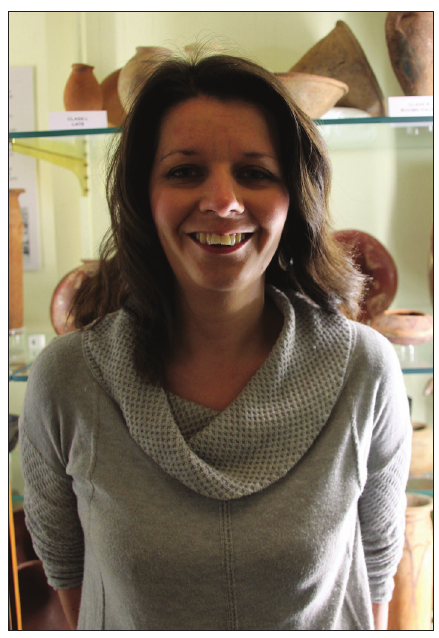
Figure 1: Alice Stevenson (Photo Lisa Daniel). Figure 2: Kris Lockyear, holding his award (Photo Charlotte